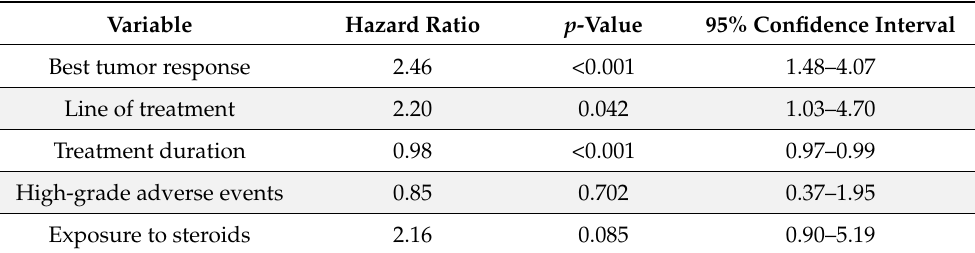
Table 2. Multivariable analysis for progression-free